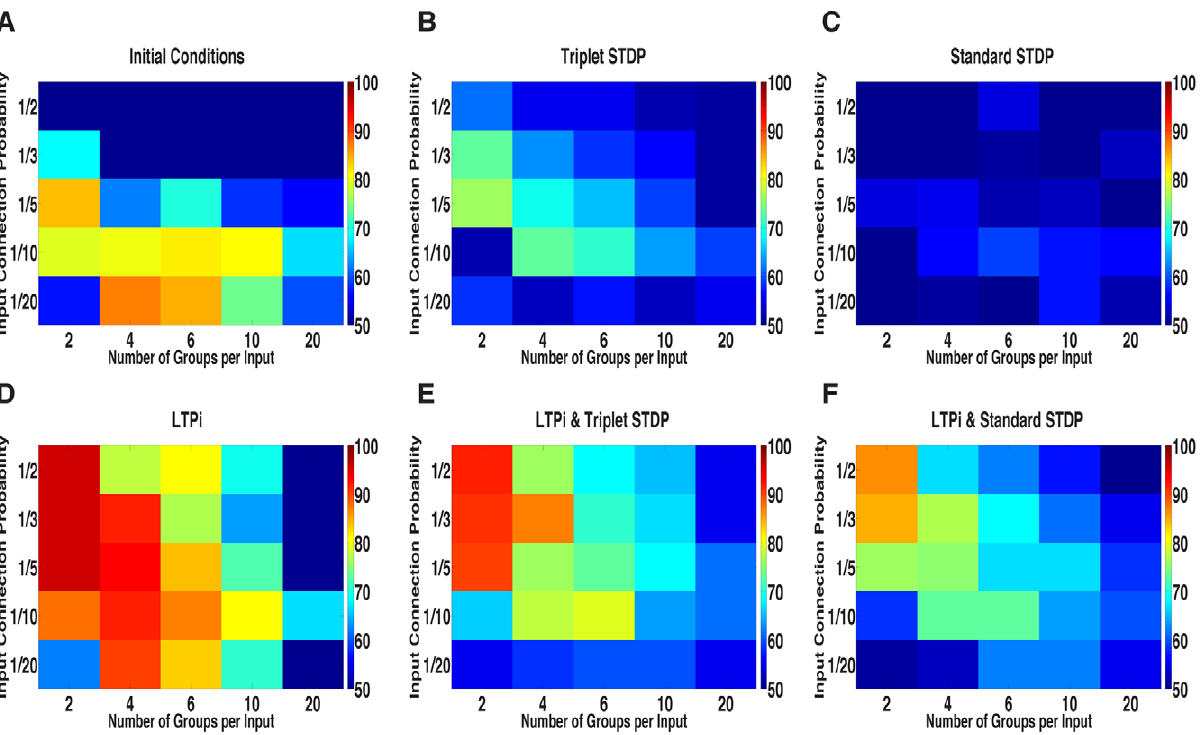
Figure 7. Decision-making performance. In all but one network, learning is required for reliable decision-making. A . One out of 25 initial networks generate decisions above criterion. B&C . Triplet but not Standard STDP generates one network near criterion for reliable decisions but no networks demonstrate reliable decisions. D . LTPi alone demonstrates the strongest decision-making networks performances, consistent with its strong stimulus-pair selectivity. E&F . The addition of LTPi to standard or triplet STDP results in networks capable of reliable decisions and more near threshold. These results demonstrate that LTPi is required necessary for reliable decisions in addition to strong stimulus-pair specificity.